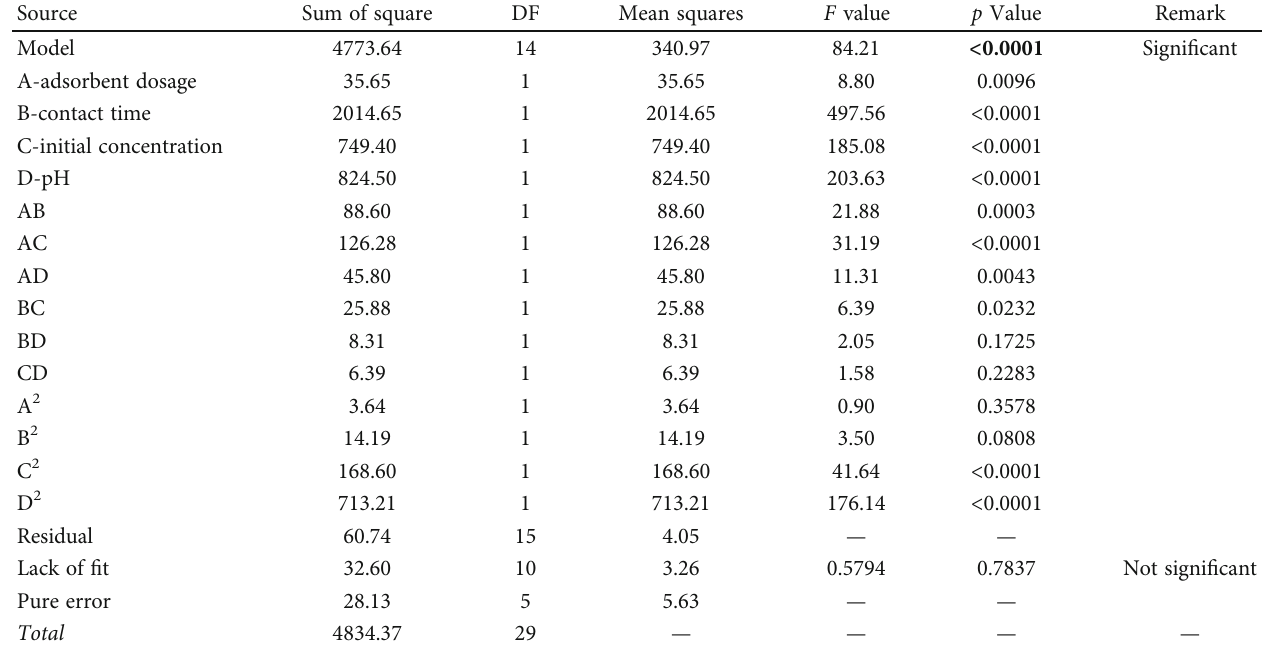
Table 6: ANOVA for quadratic model for removal of Cr(VI).